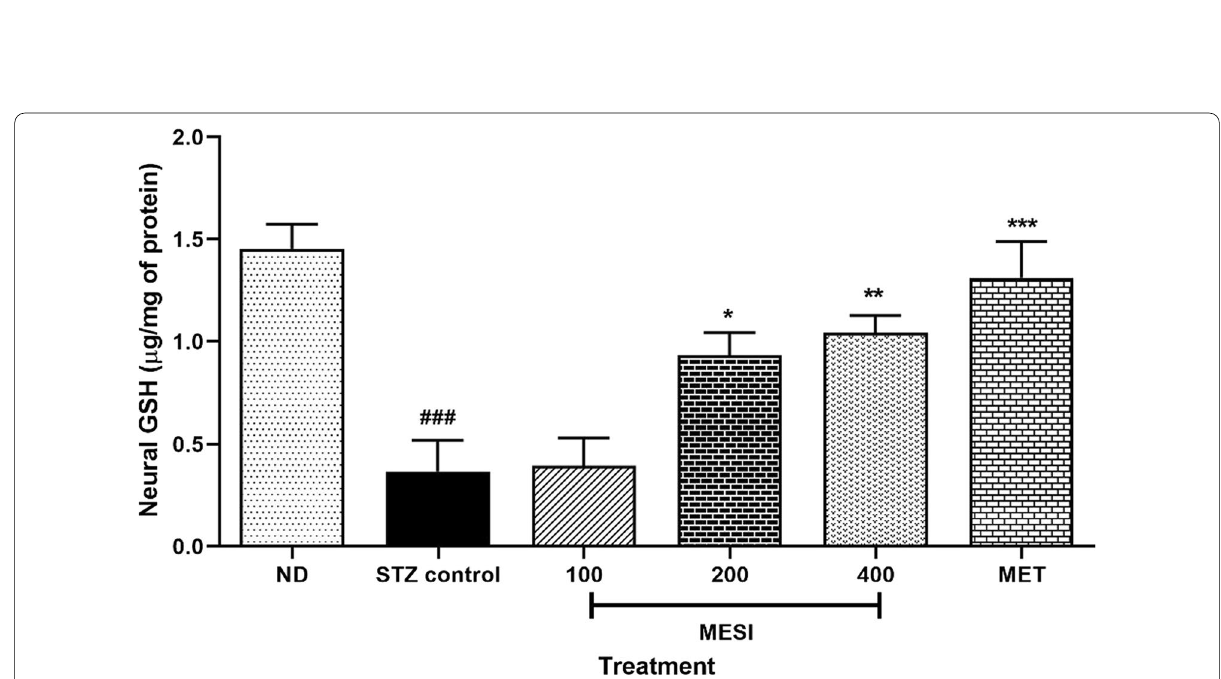
Fig. 6 Effect of MESIon diabetes-induced alterations in the reduced glutathione (GSH) level. Data are expressed as mean analyzed by one-way ANOVA followed by a post hoc Tukey’s multiple range test. *P < 0.05, **P < 0.01 for MESI, and *** P < 0.001 for metformin-treated groups compared to the diabetic (STZ) control group. ### P < 0.001 for the diabetic (STZ) control group compared to the normal non-diabetic group. MESI (100), MESI (200), and MESI (400): Methanolic extract of Sphaeranthus indicus Linn (MESI) 100, 200, and 400 mg/ kg, p.o. treated